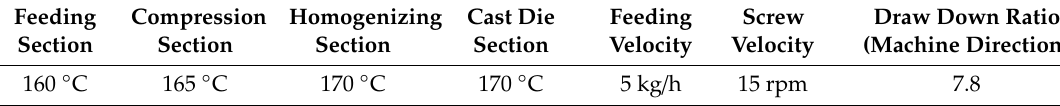
Table 2. Parameters of co-extrusion casting